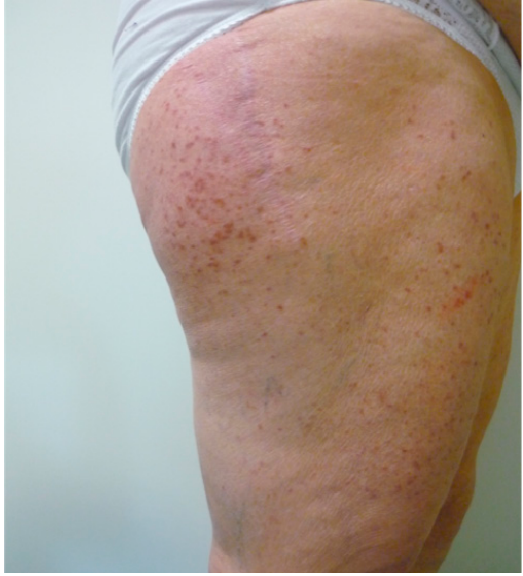
Figure 3. Yellowish to deep brown macules and papules on thighs in an old woman affected by mastocytosis.